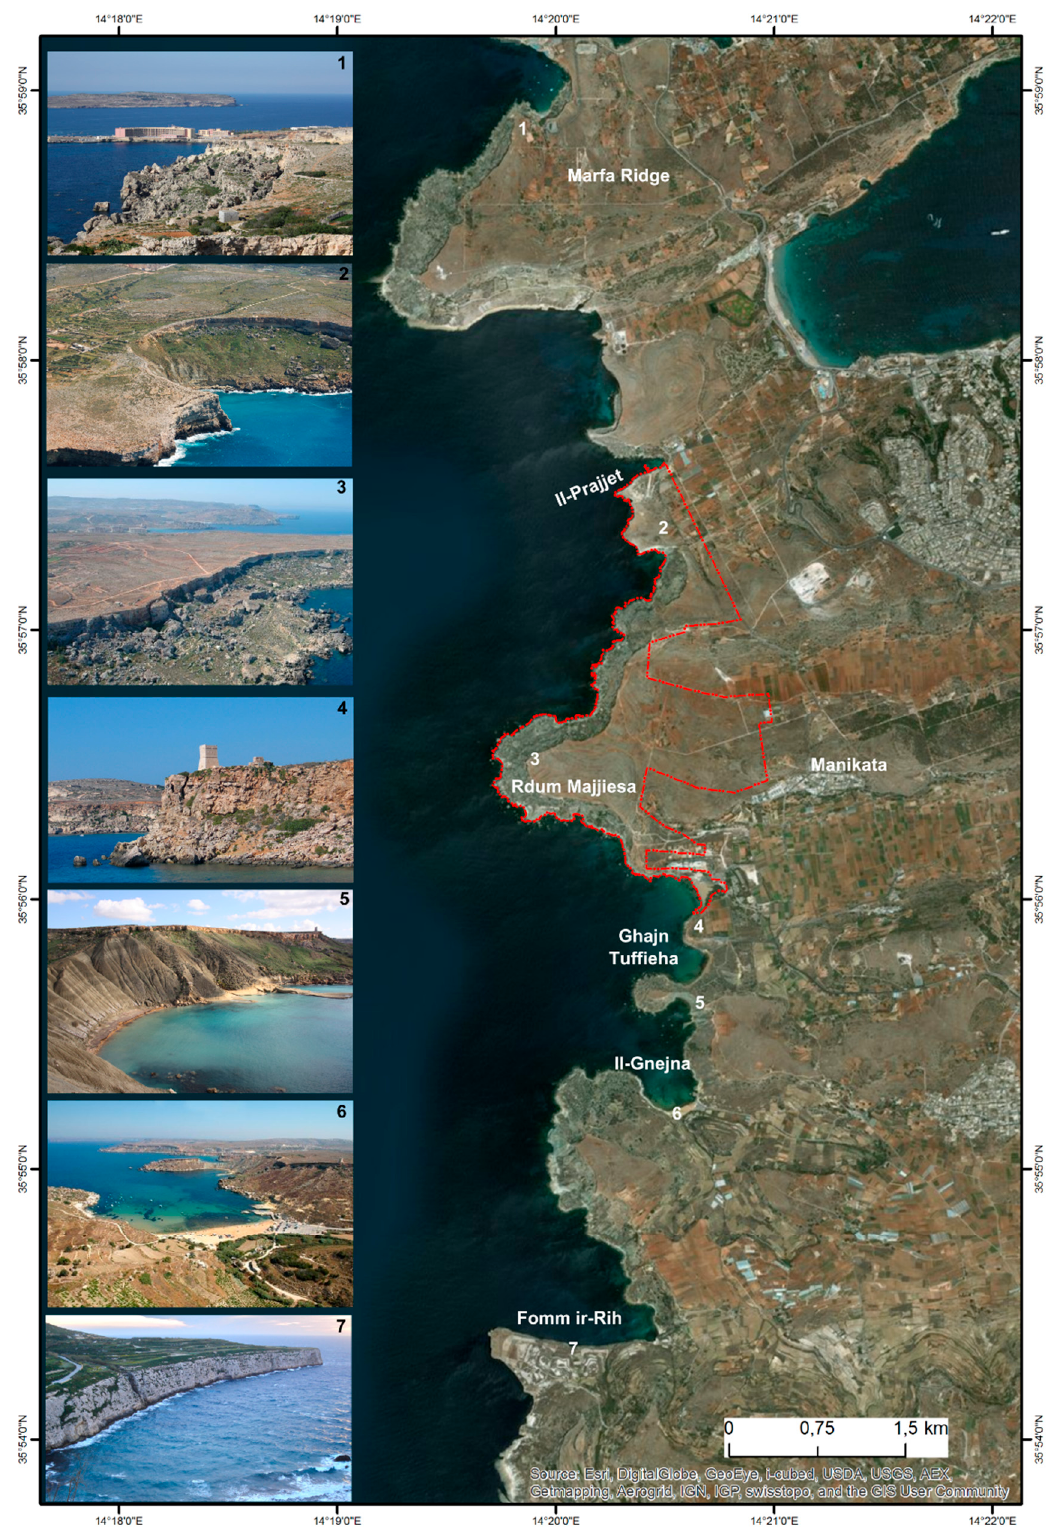
Figure 2. Outstanding geomorphological features of Malta study area (GEOMAL): ( 1 – 3 ) areas affected by block sliding favoured by the superimposition of Upper Coralline Limestone on Blue Clays; ( 4 ) Upper Coralline Limestone steep cliff with a watchtower on top, dating from 1637; ( 5 ) badland topography on a steep Blue Clay slope; ( 6 ) pocket beach; ( 7 ) the Great Fault scarp, one of the most significant structural features of the island. Red dashed-line delimits Il-Majjistral Nature and History Park boundary.